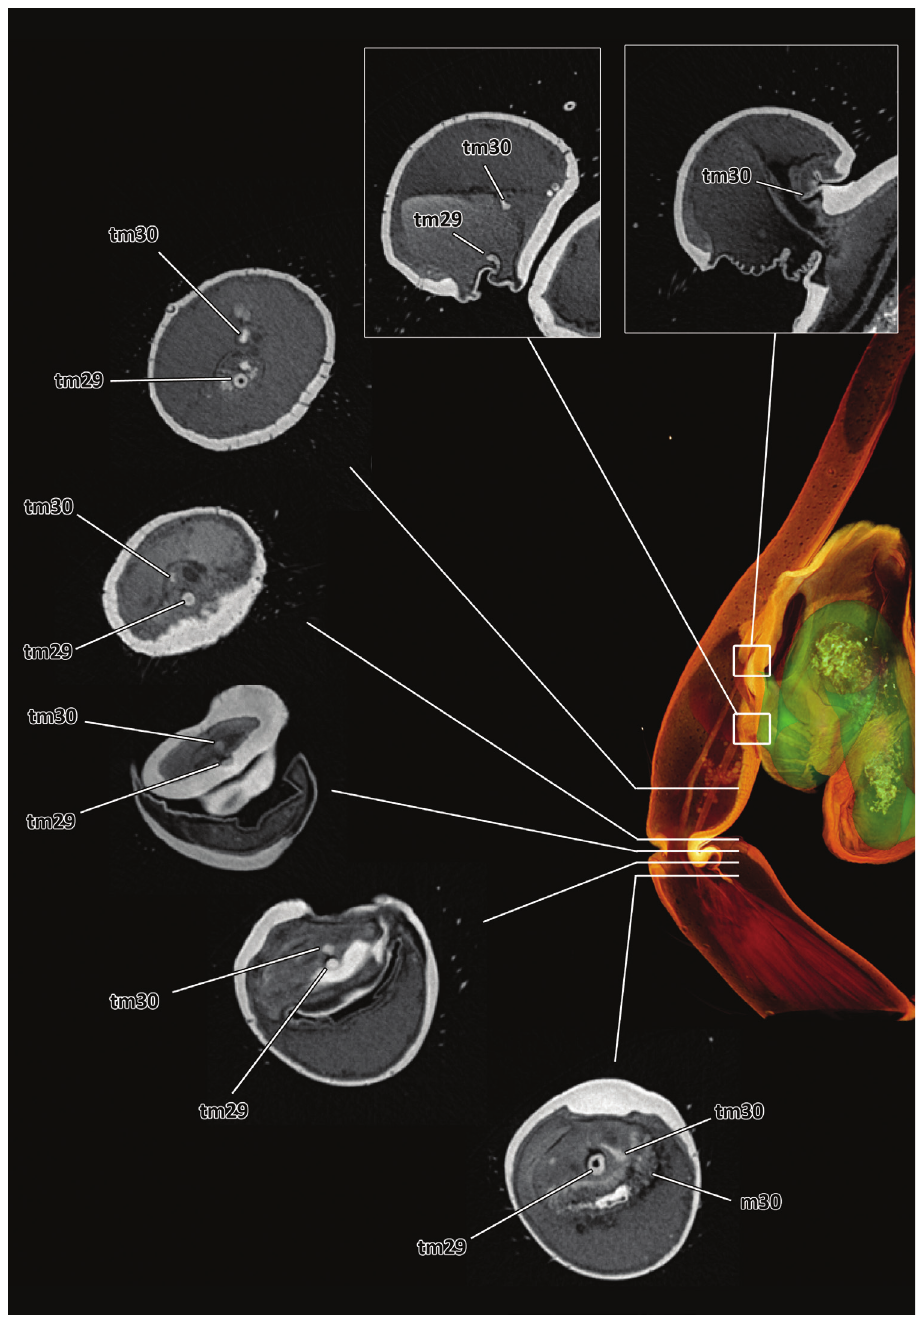
Figure 11. Series of virtual cross sections through the left male palp of Thaida chepu showing the course of the two